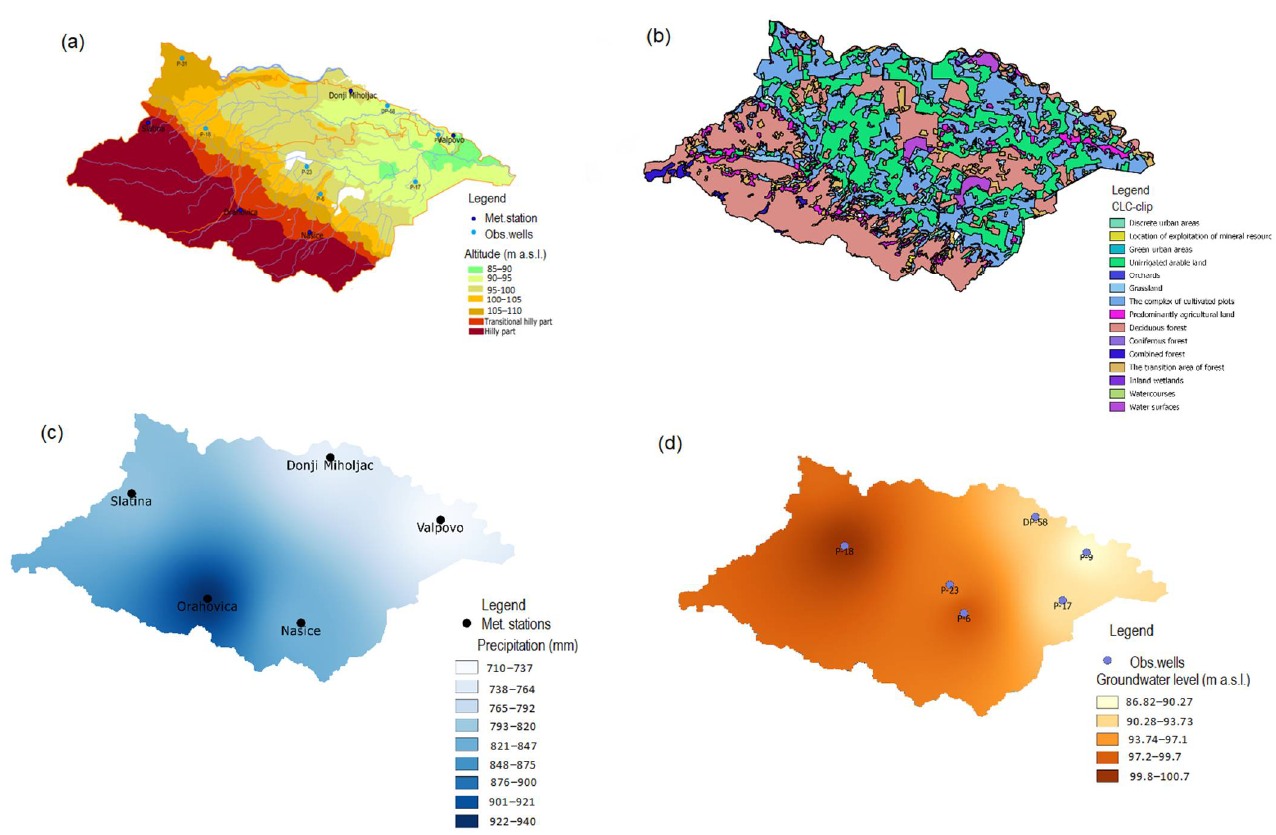
Figure 2. ( a ) Altitude map of the catchment area, ( b ) vegetation cover, ( c ) annual precipitation distribution, ( d ) mean groundwater level. Table 1. Basic catchment